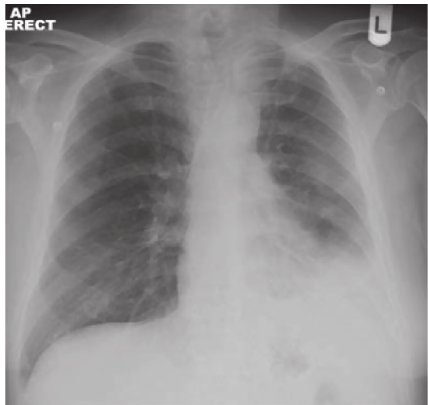
Figure 4: CXR on readmission.